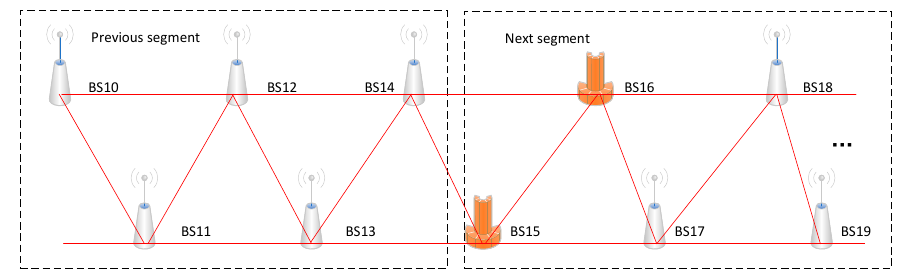
Figure 10. Presentation of backward calibration process.